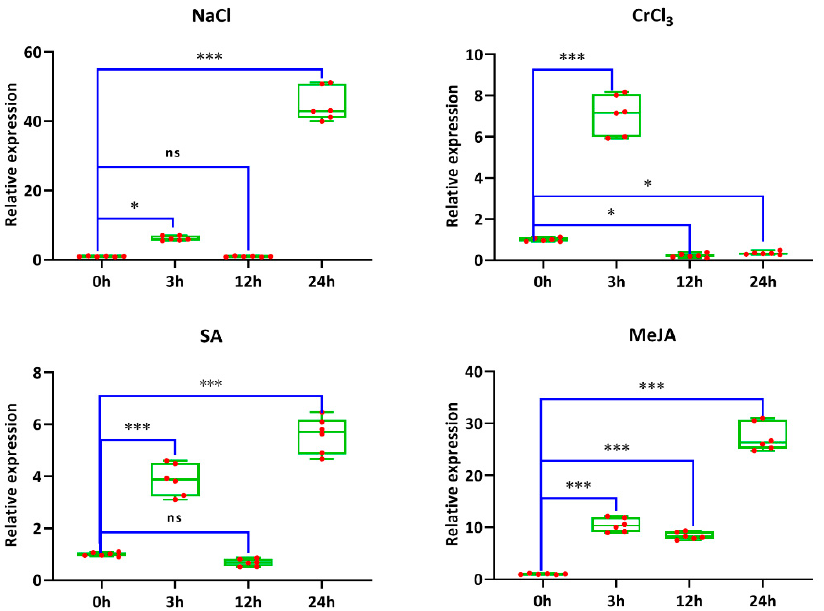
Figure 5. Expression profile of the ScCaM gene under different stresses in sugarcane. GAPDH was used for the normalization of the transcript levels. Asterisks indicate a significant difference, as determined by a one-way ANOVA (treatment: control/salt) between subjects, followed by Duncan’s new multiple range test (ns indicates no significant difference, * p < 0.05, *** p < 0.01). The F-statistics, degrees of freedom, and p -value for each factor or interaction were shown in Table S3.